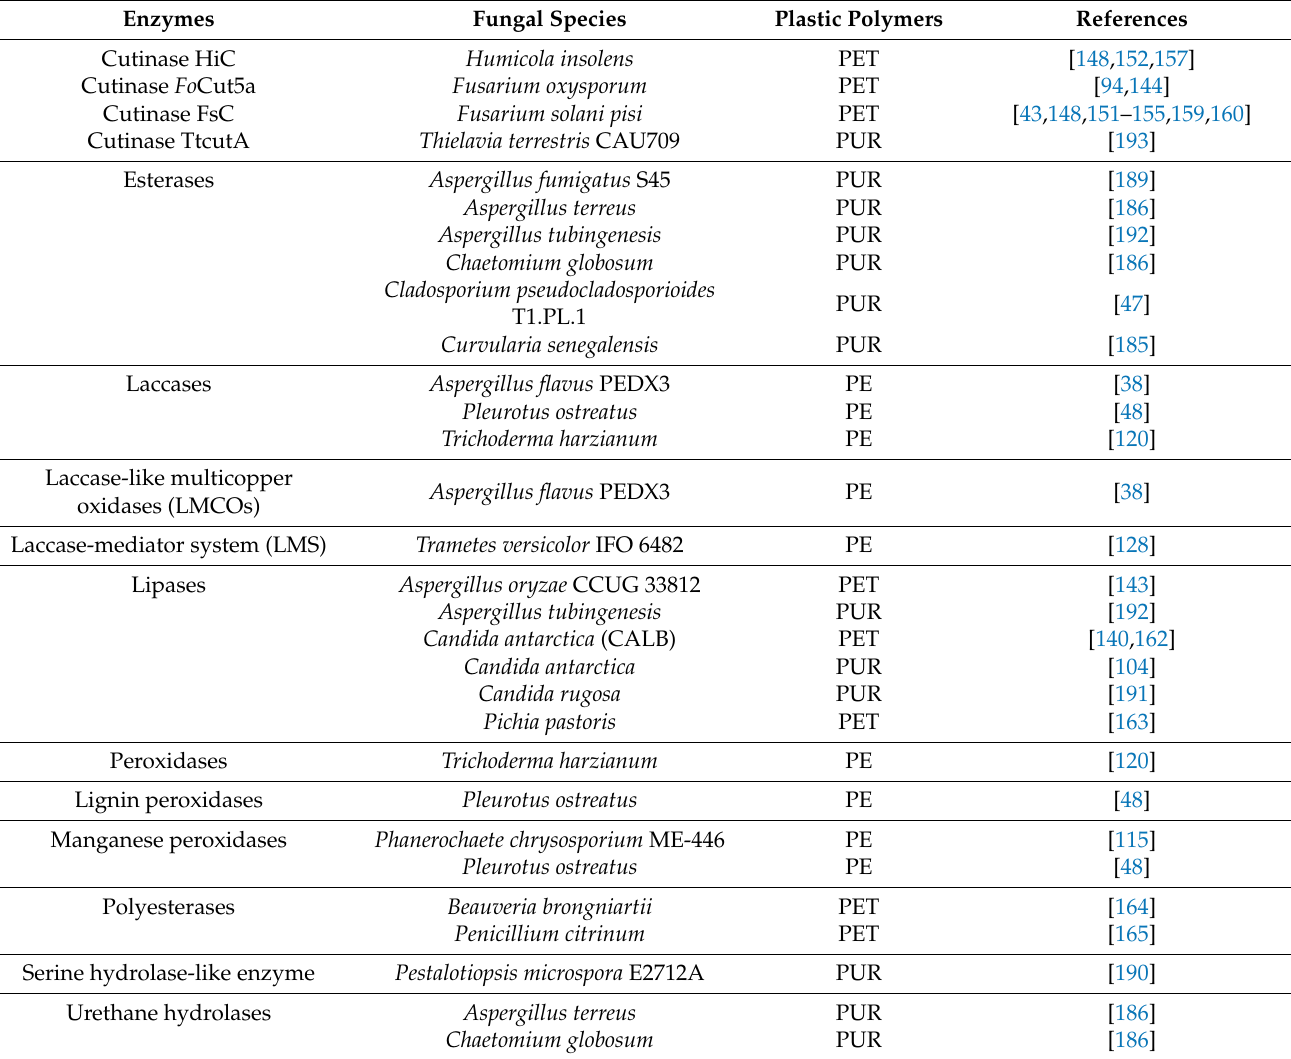
Table 8. Fungal enzymes documented as able to degrade plastics and the relative producing fun- gal